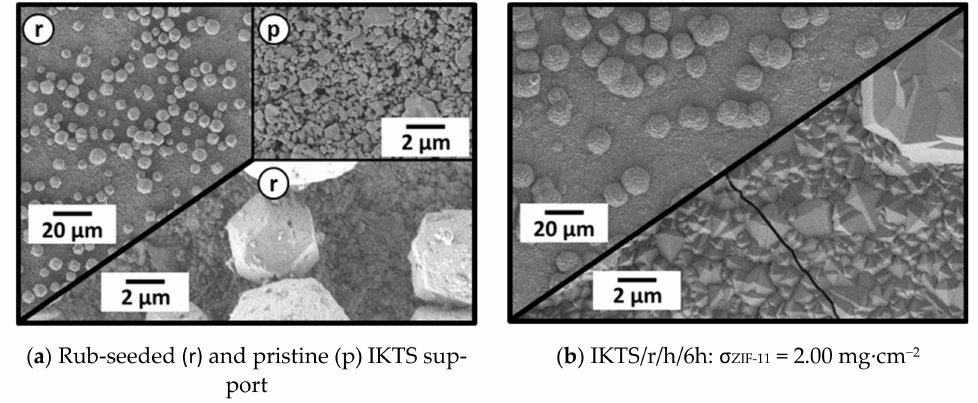
Figure 15. SEM images (500 × and 5000 × ) of an IKTS support ( α -Al 2 O 3 ) ( a ) after rub seeding and ( b ) after 6 h of secondary growth in DEF at 60 ◦ C.